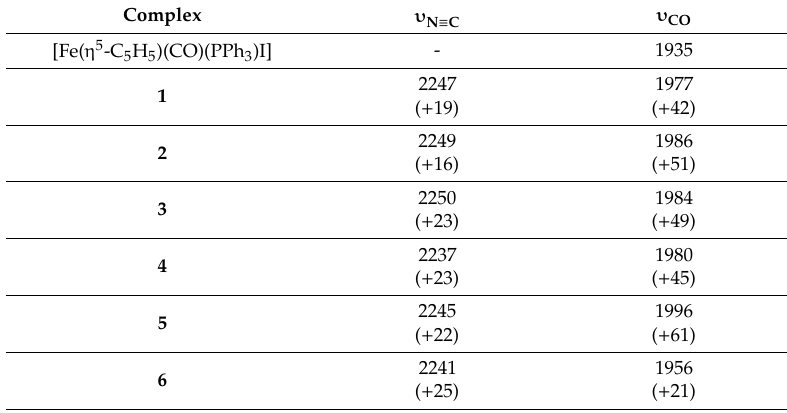
Table 2. Characteristic stretching frequencies (cm − 1 ). Values in brackets represent the di ff erences between the υ (N ≡ C) of coordinated and free nitrile or between the υ (CO) of [Fe( η 5 -C 5 H 5 )(CO)(PPh 3 )I] and compounds 1 – 6